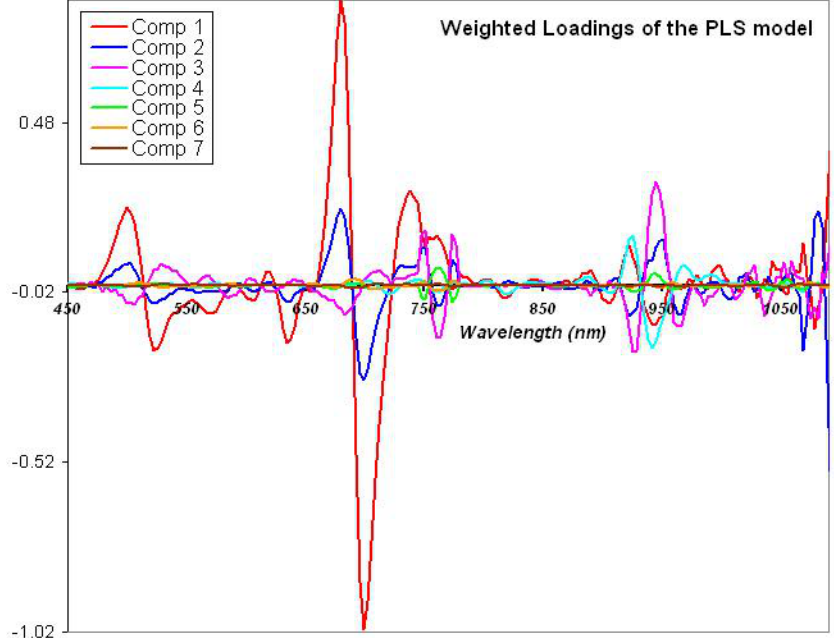
Figure 6. Coefficients (―loadings‖) of the PLSR weighted by the corresponding eigen value for each of the seven selected